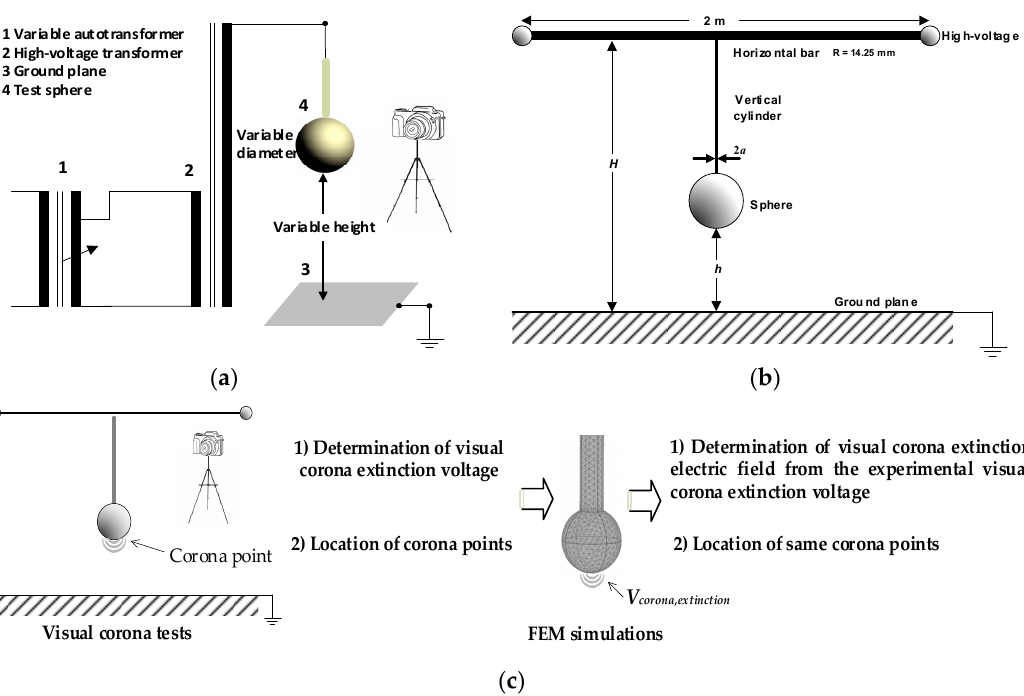
( d ) Figure 3. Positive polarity dc corona (sphere diameter of 20 mm, h = 15 cm). ( a ) Initial corona glow at +55.5 kV; ( b ) Corona glow and streamer initiation at +56.0 kV; ( c ) Advanced positive corona combining glow and streamers at +62 kV; ( d ) Spark breakdown at approximately +80 kV.